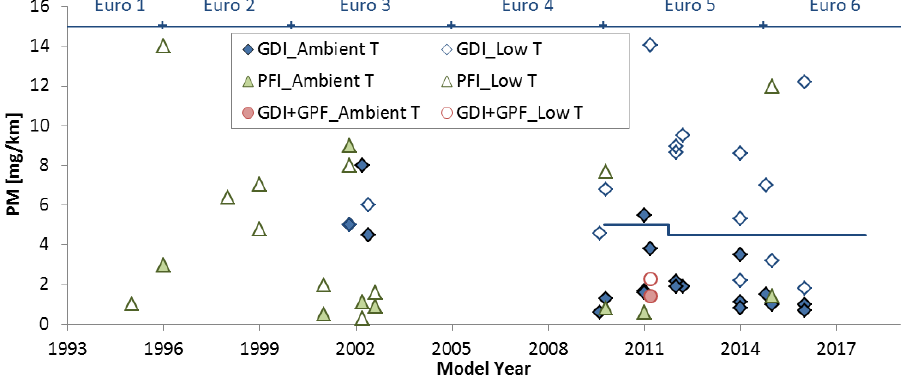
Figure 4. Particulate matter (PM) mass emissions for gasoline direct injection (GDI) (lower panel) and port fuel injection (PFI) (upper panel) vehicles at different ambient temperatures. “Ambient T” refers to approximately 23 ° C. “Low T” refers to − 7 ° C. Solid line shows PM limits for GDI vehicles at 23 ° C (only EU).